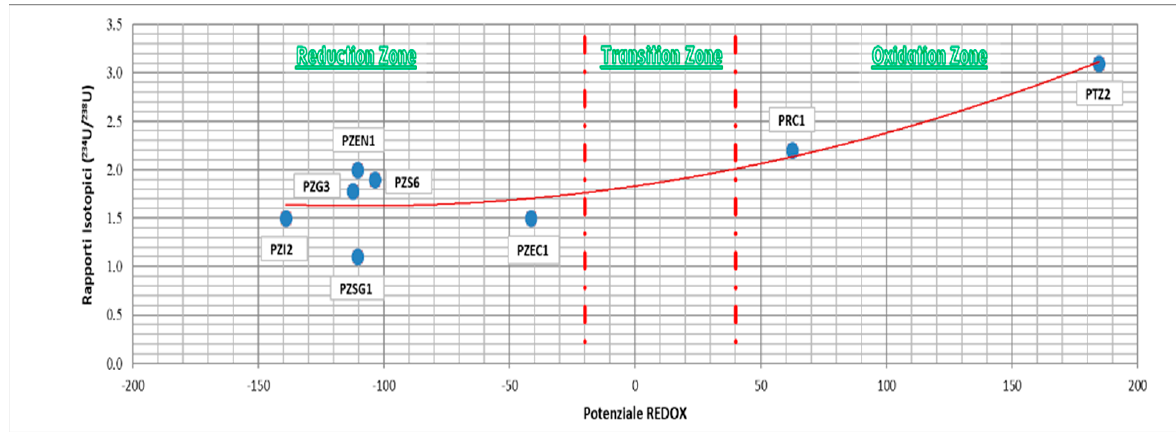
Figure 13. Graph of Uranium Isotope Ratios ( 234 U/ 238 U) in Monitored Piezometers (Median Values) [6].